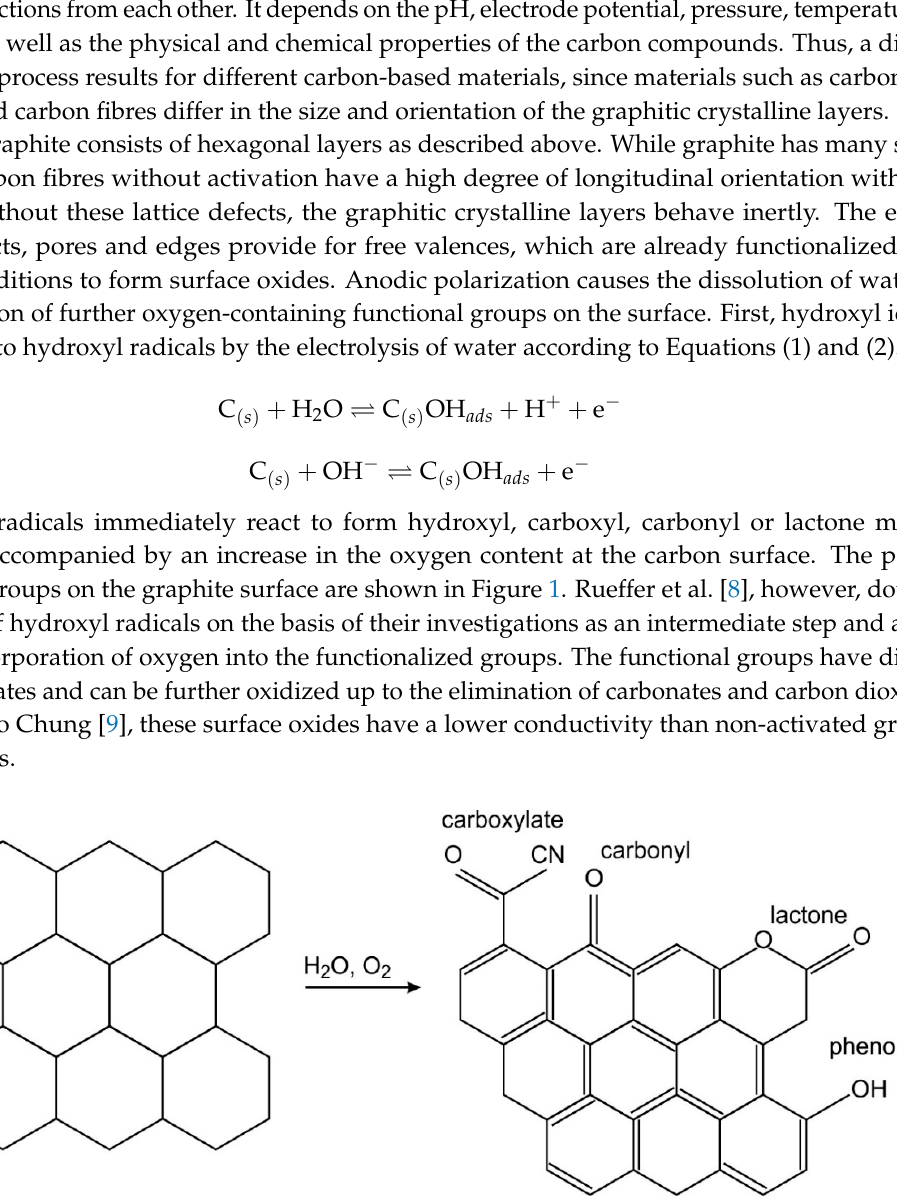
Figure 1. Formation of surface oxides in graphite [7].